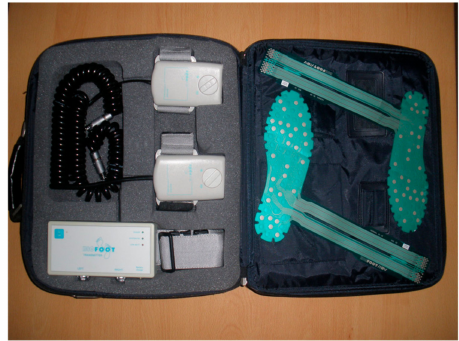
Figure 1. Biofoot in-shoe system.